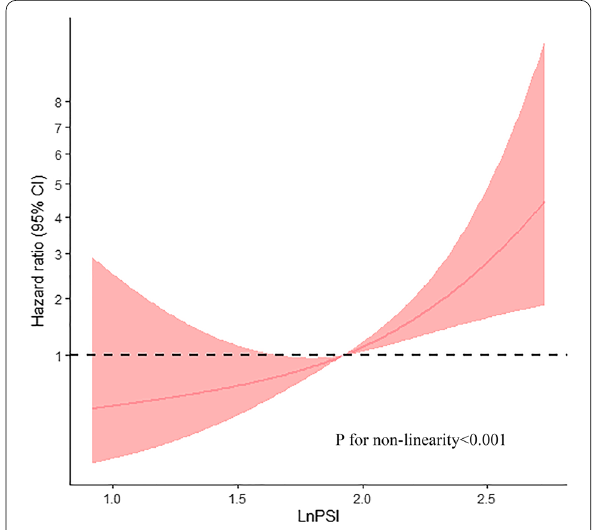
Fig. 3 Restricted cubic splines of nonlinear association between LnPSI and hazard ratio. The bold red lines indicate the pooled restricted cubic spline model, and the red filled area indicates the 95% confidence intervals of the pooled curve. PSI: post-systolic